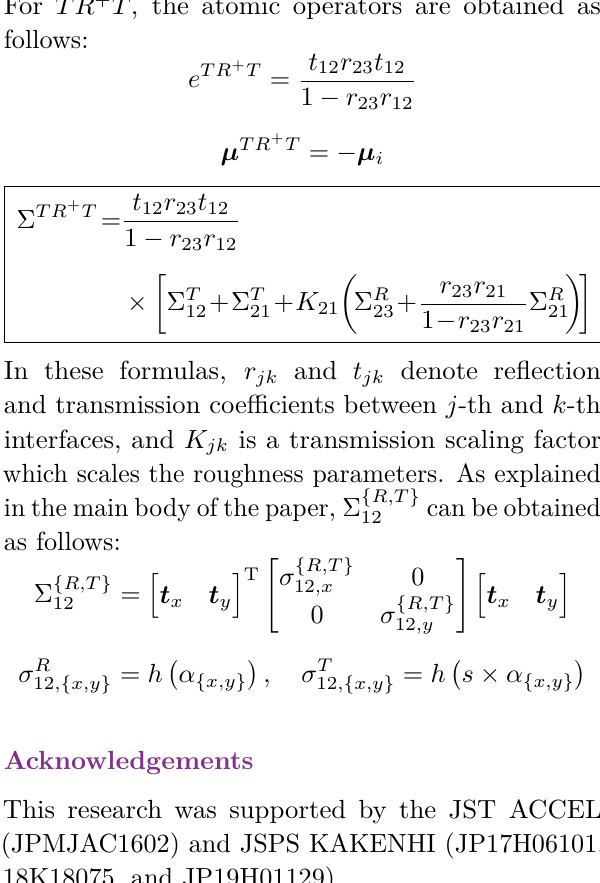
supplementary materials are available in the online version of this article at